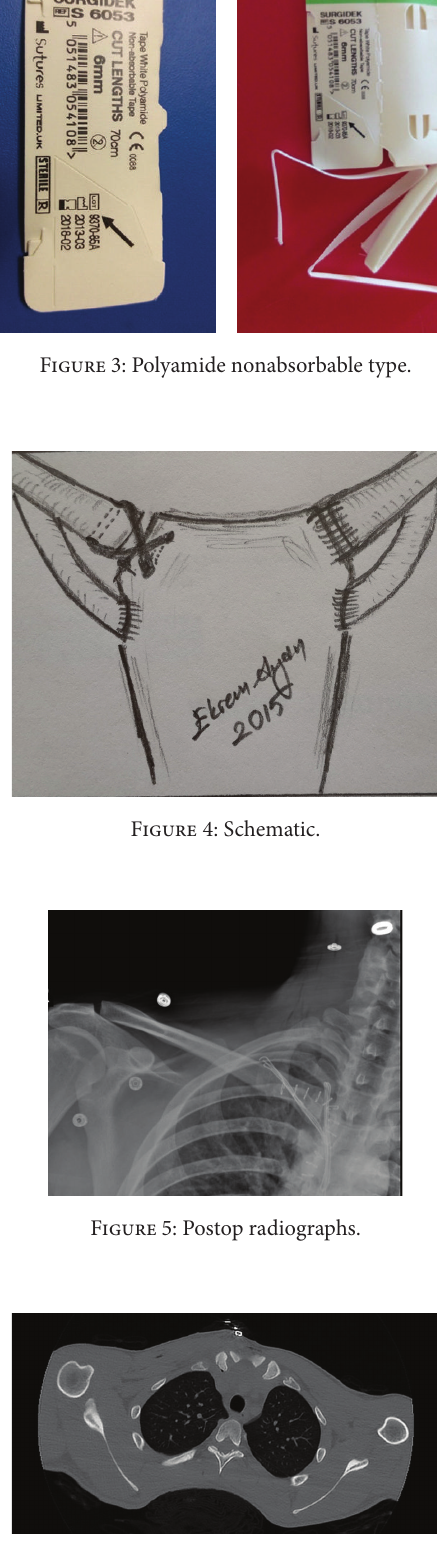
Figure 6: Postop